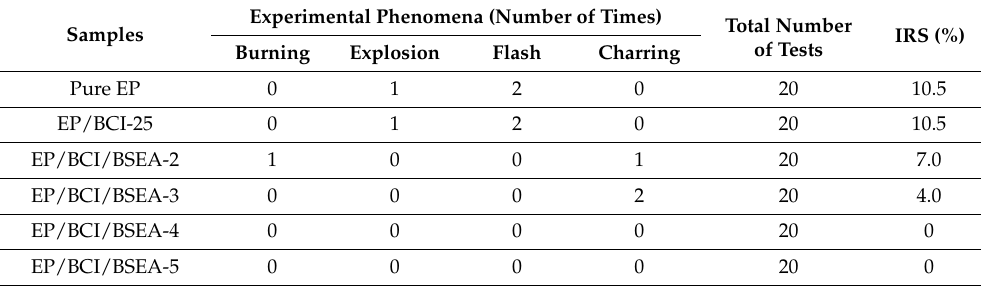
Table 2. Impact sensitivity phenomena of modified